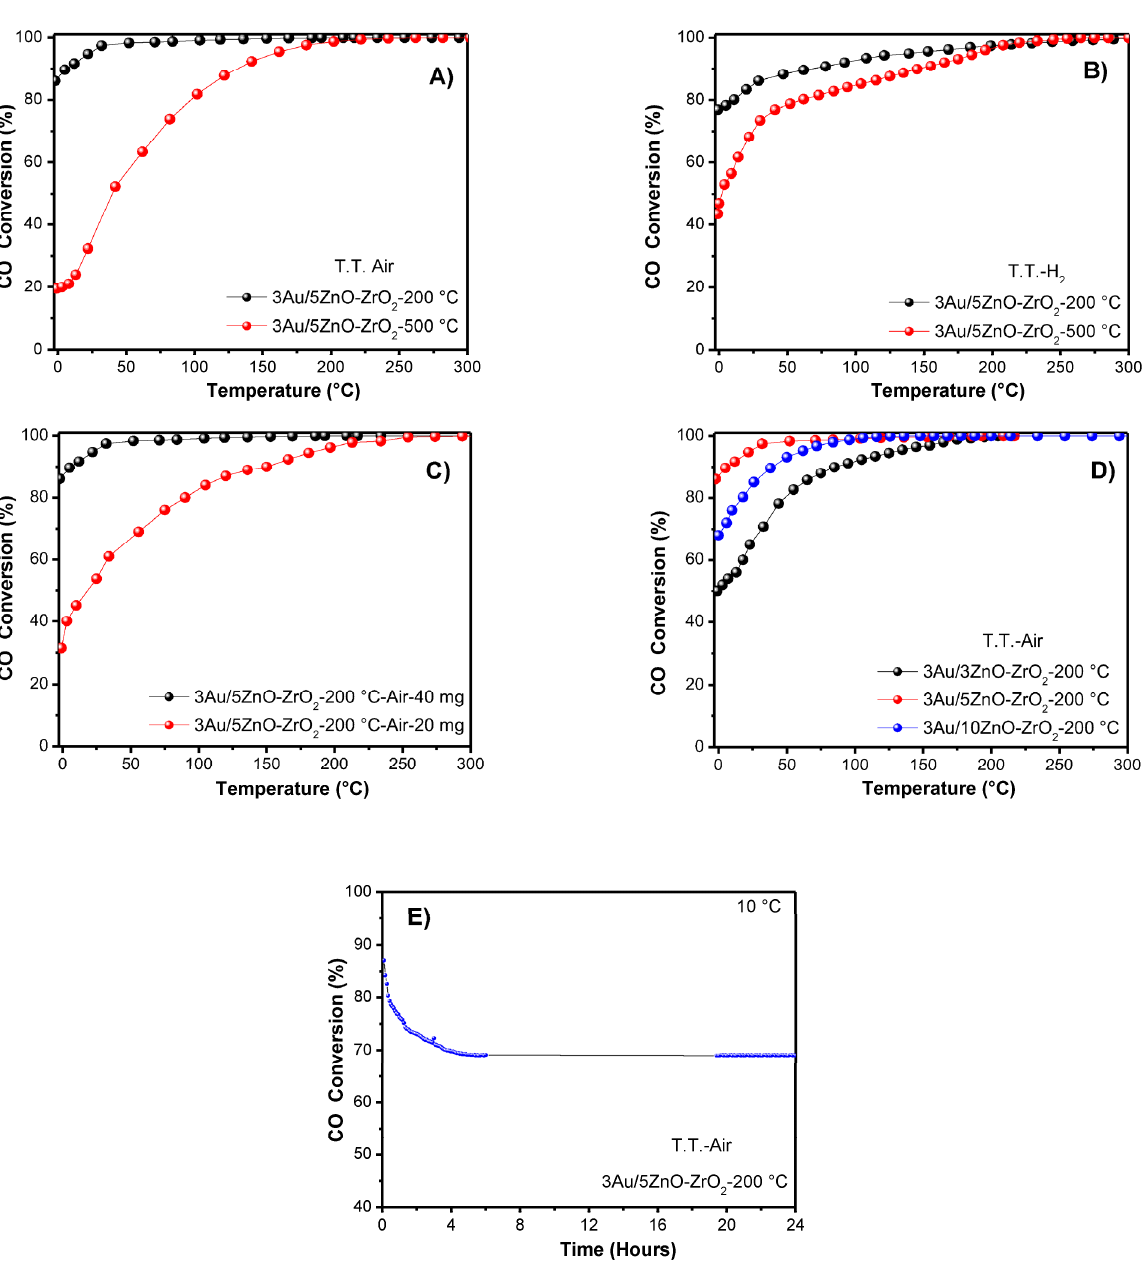
Figure 8. CO oxidation light-off profiles: ( A ) CO conversions for 3Au/5ZnO − ZrO 2 at different tem- peratures (200 and 500 °C), treated under air atmosphere, GHSV of 46,000 h − 1; ( B ) CO conversions for 3Au/5ZnO − ZrO 2 at different temperatures (200 and 500 °C), under H 2 atmosphere, GHSV of 46,000 h − 1; ( C ) CO conversions for 3Au/5ZnO − ZrO 2 for 40 and 20 mg of catalysts, treated under air atmosphere; ( D ) comparison of CO conversions for the 3Au/3ZnO − ZrO 2 , 3Au/5ZnO − ZrO 2 , and 3Au/10ZnO − ZrO 2 catalysts at different ZnO amounts (3, 5, and 10 wt. %), thermally treated under air atmosphere at 200 °C; and ( E ) temporal stability for 24 h for 3Au/5ZnO − ZrO 2 at 10 °C using 40 mg of catalyst under dry conditions. 2.6.2. Effect of Using Hydrogen or Air in the CO Oxidation The effect of the gas used in the thermal treatment of the catalysts with either air or hydrogen was tested for the 3Au/ZrO 2 , 3Au/ZnO, and 3Au/5ZnO − ZrO 2 catalysts at 200 and 500 °C, respectively (see Figure 8A,B). In this sense, earlier reports have shown that samples synthesized by the method of deposition-precipitation with urea have resulted in Au 3+ species that can be reduced in air or hydrogen toward Au 0 through different steps [33]. It is shown in Figure 8A,B that the activity displayed by the 3Au/5ZnO − ZrO 2 catalysts was higher than the activity displayed by those supported on single oxides when the sam- ples were thermally treated in hydrogen and air at 200 °C, reaching 78% and 86% conver- sion at 0 °C, respectively. As for the 3Au/5ZnO − ZrO 2 catalysts, they were also treated in hydrogen and air at 500 °C (Figure 8A,B). In this case, the CO conversion decreased nota- bly with regard to the same samples treated at 200 °C, reaching 19% and 42% conversion at 0 °C, respectively. In this way, the thermal treatment at 500 °C affects the properties of the 3Au/5ZnO − ZrO 2 catalyst, mainly modifying the gold particle size, morphology, and metal dispersion. In Figure 8C, the effect of the gas hourly space velocity (GHSV) is shown for the most active 3Au/5ZnO − ZrO 2 catalyst using 20 and 40 mg of catalyst, representing a GHSV of